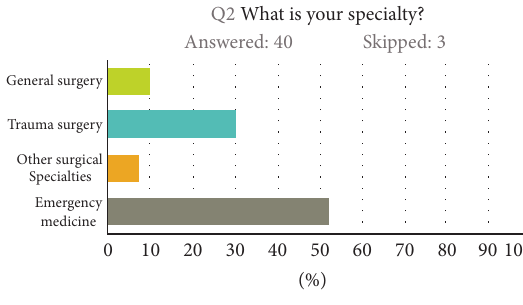
Figure 1: Participants by